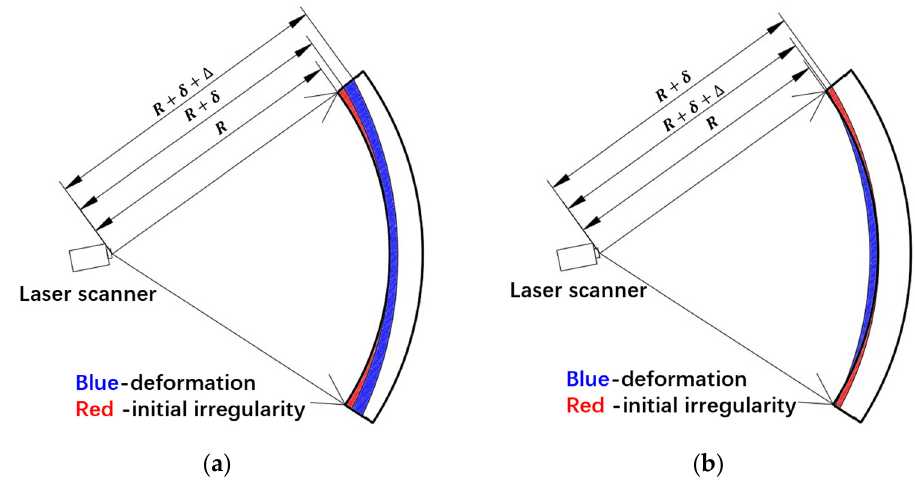
Figure 15. Possible initial irregularity of ( a ) segment B2, L1, and ( b ) segment L2.